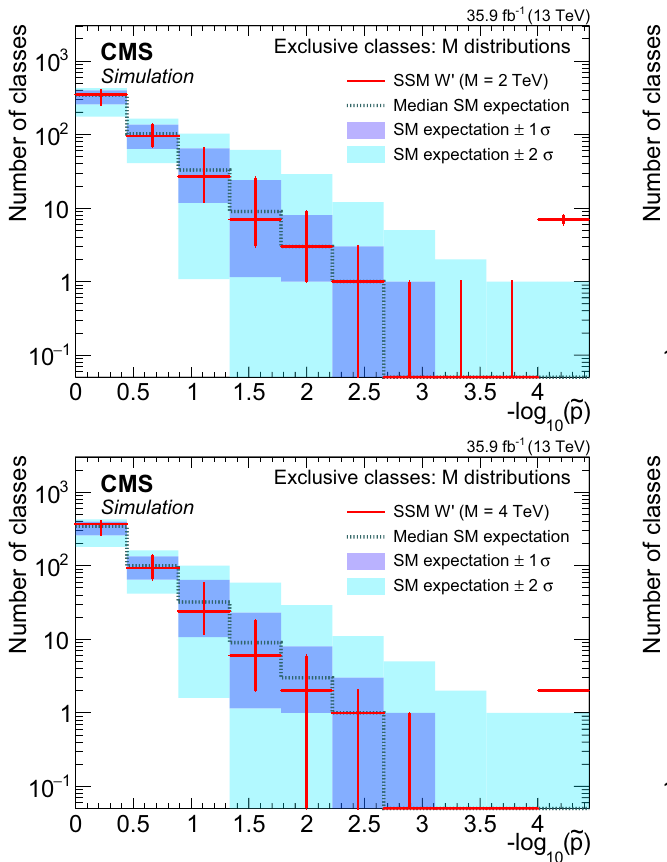
right), 4 (lower left), and 5TeV (lower right). The uncertainty in the )withassumed distribution of ˜ p values for the signal is obtained from the variations in T the pseudo-data performed with the W (cid:11) signal simulation